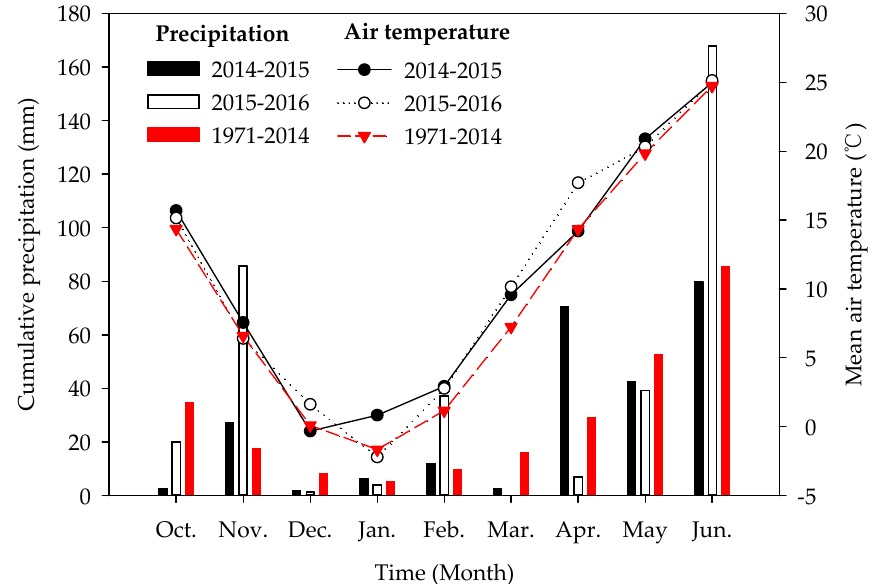
Figure 1. Cumulative monthly precipitation and mean monthly air temperature of winter wheat during 2014–2016 and 1971–2014.